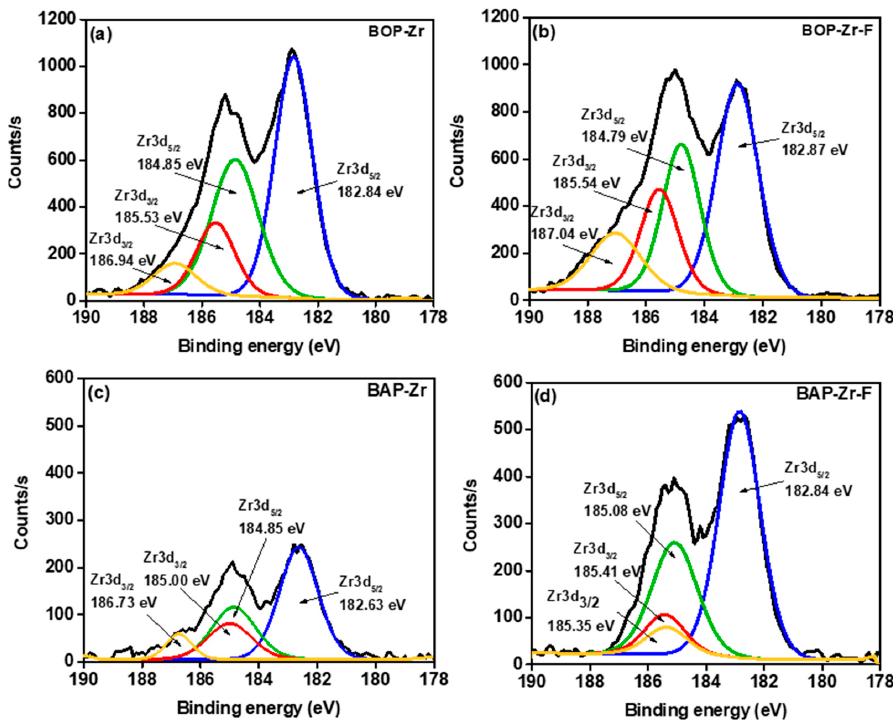
Figure 10. Deconvoluted XPS spectra for O1s, ( a ) BOP-Zr, ( b ) BOP-Zr-F, ( c ) BAP-Zr, and ( d ) BAP-Zr-F.